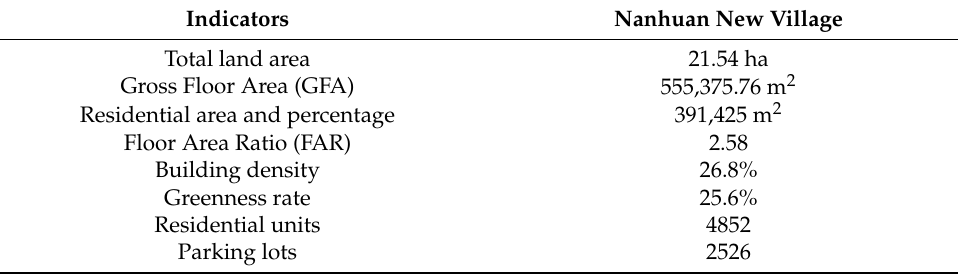
Table 4. Basic information of ‘3H’ Nanhuan New Village.